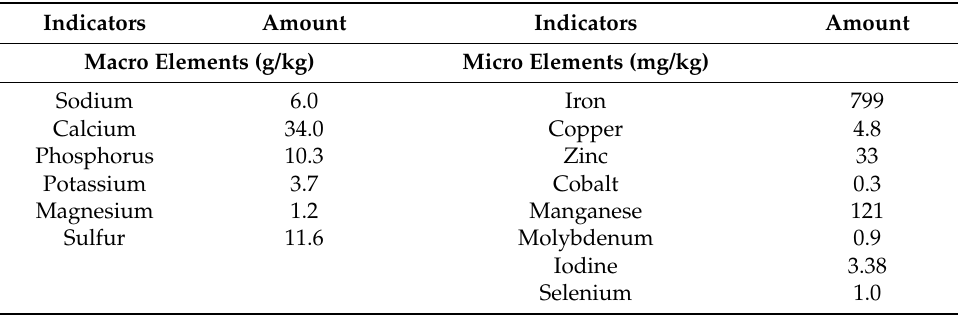
Table 4. The content of macro and micro elements in Agro-Matic protein